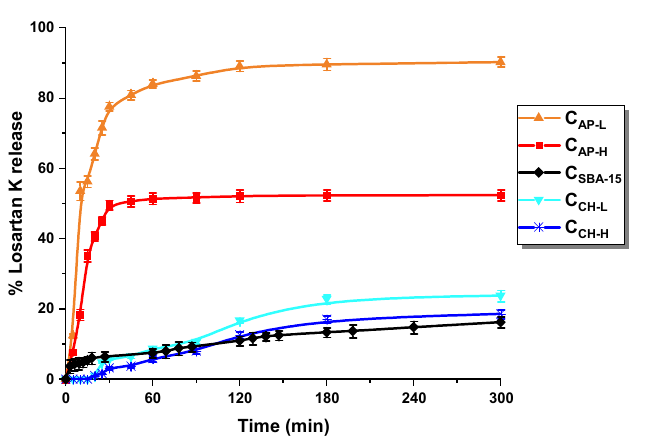
Figure 9. Release profiles of losartan potassium from carbon carriers: C AP-L , C AP-H , C SBA-15 , C CH-L , and C CH-H in acidic medium (HCl 0.1 mol L − 1 ).